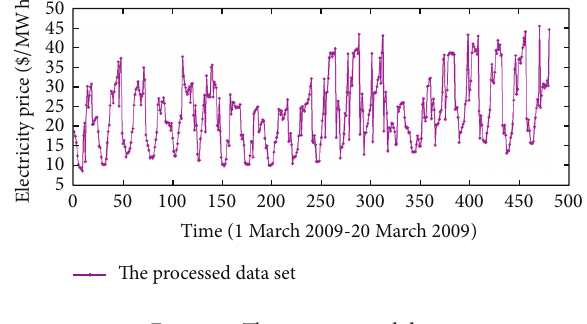
Figure 5: The preprocessed data.